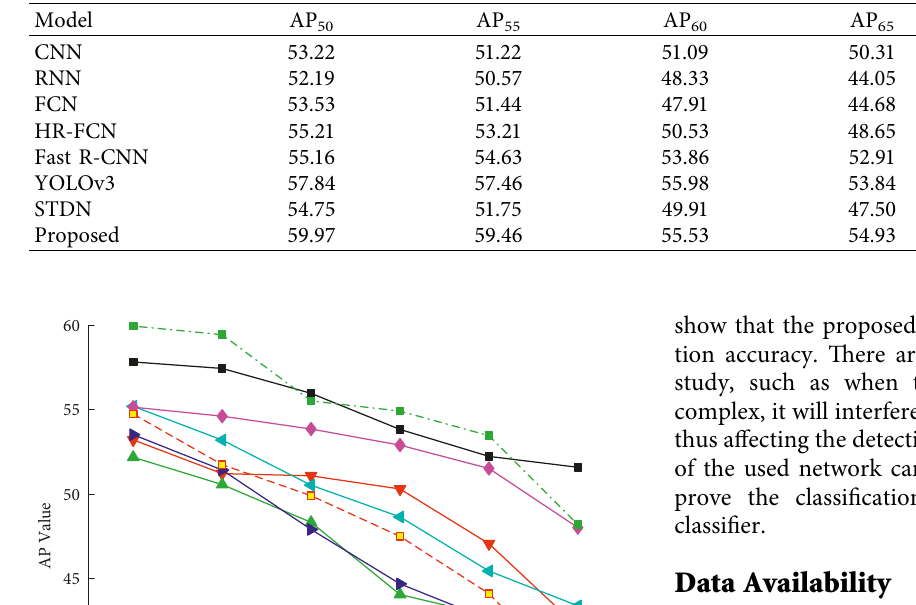
Table 5: AP value on COCO